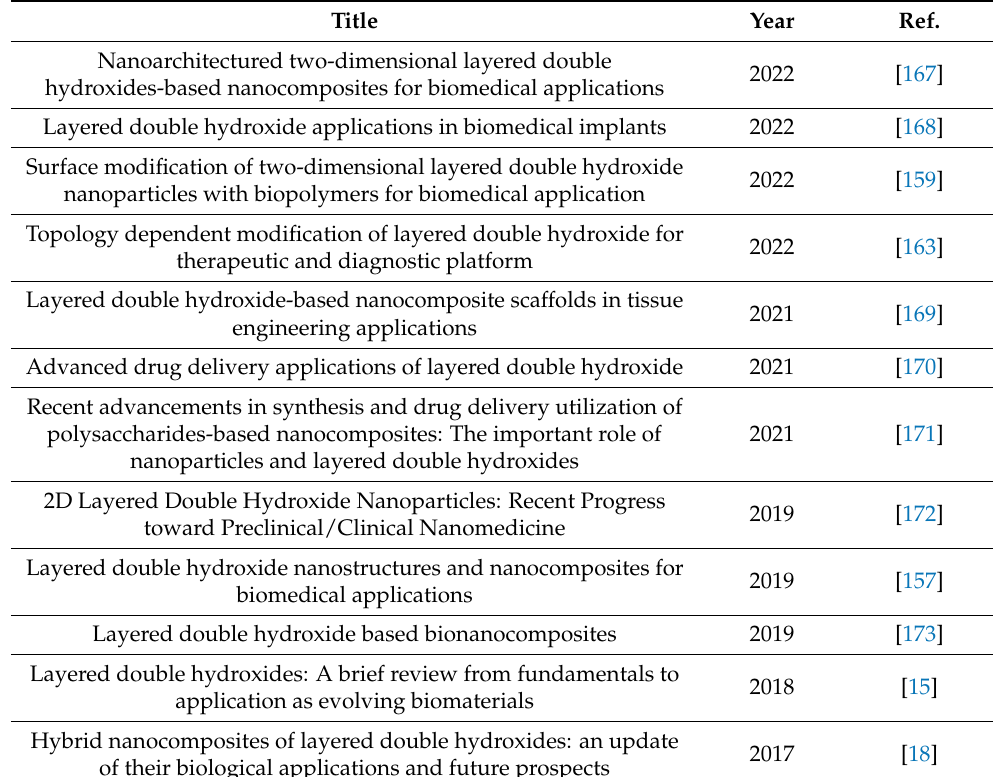
Figure 13. Polymer/LDH nanocomposites: ( A ) microcapsules and microspheres-based delivery systems; ( B ) intercalated and exfoliated nanocomposites. Table 1. Review papers focusing on nanocomposites based on polymers and layered double hydroxides for pharmaceutical and medical applications published in 2017 – 2022.